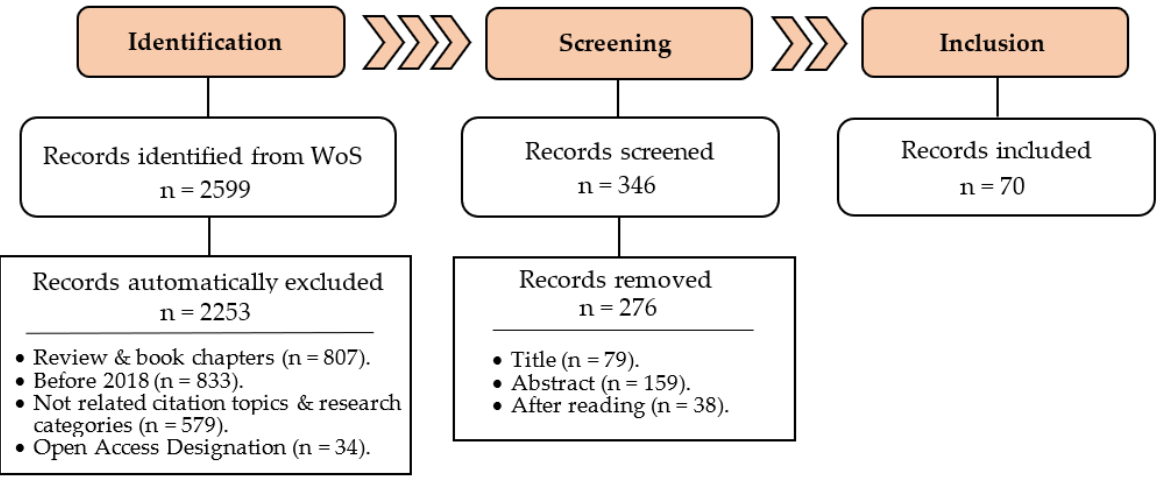
Figure 1. Flowchart summarizing the literature selection process according to PRISMA methodol-